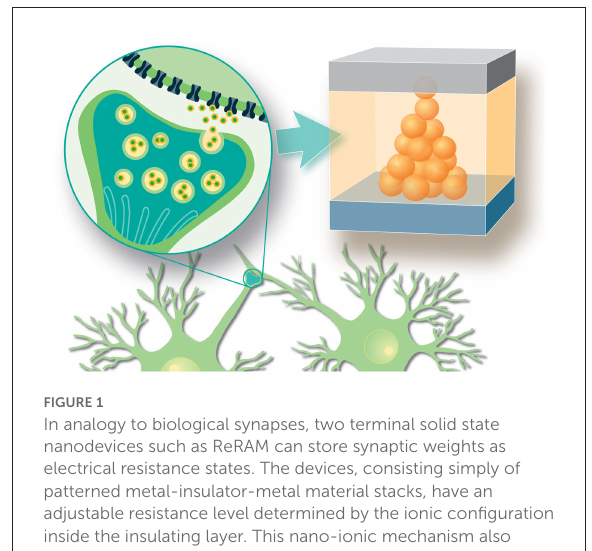
FIGURE1 In analogy to biological synapses, two terminal solid state nanodevices such as ReRAM can store synaptic weights as electrical resistance states. The devices, consisting simply of patterned metal-insulator-metal material stacks, have an adjustable resistance level determined by the ionic configuration inside the insulating layer. This nano-ionic mechanism also exhibits non-ideal properties such as stochasticity and